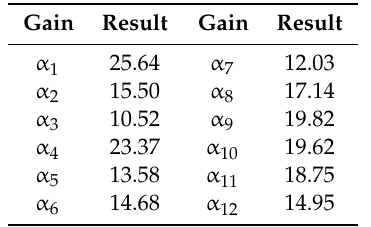
Table 2. Results of the genetic